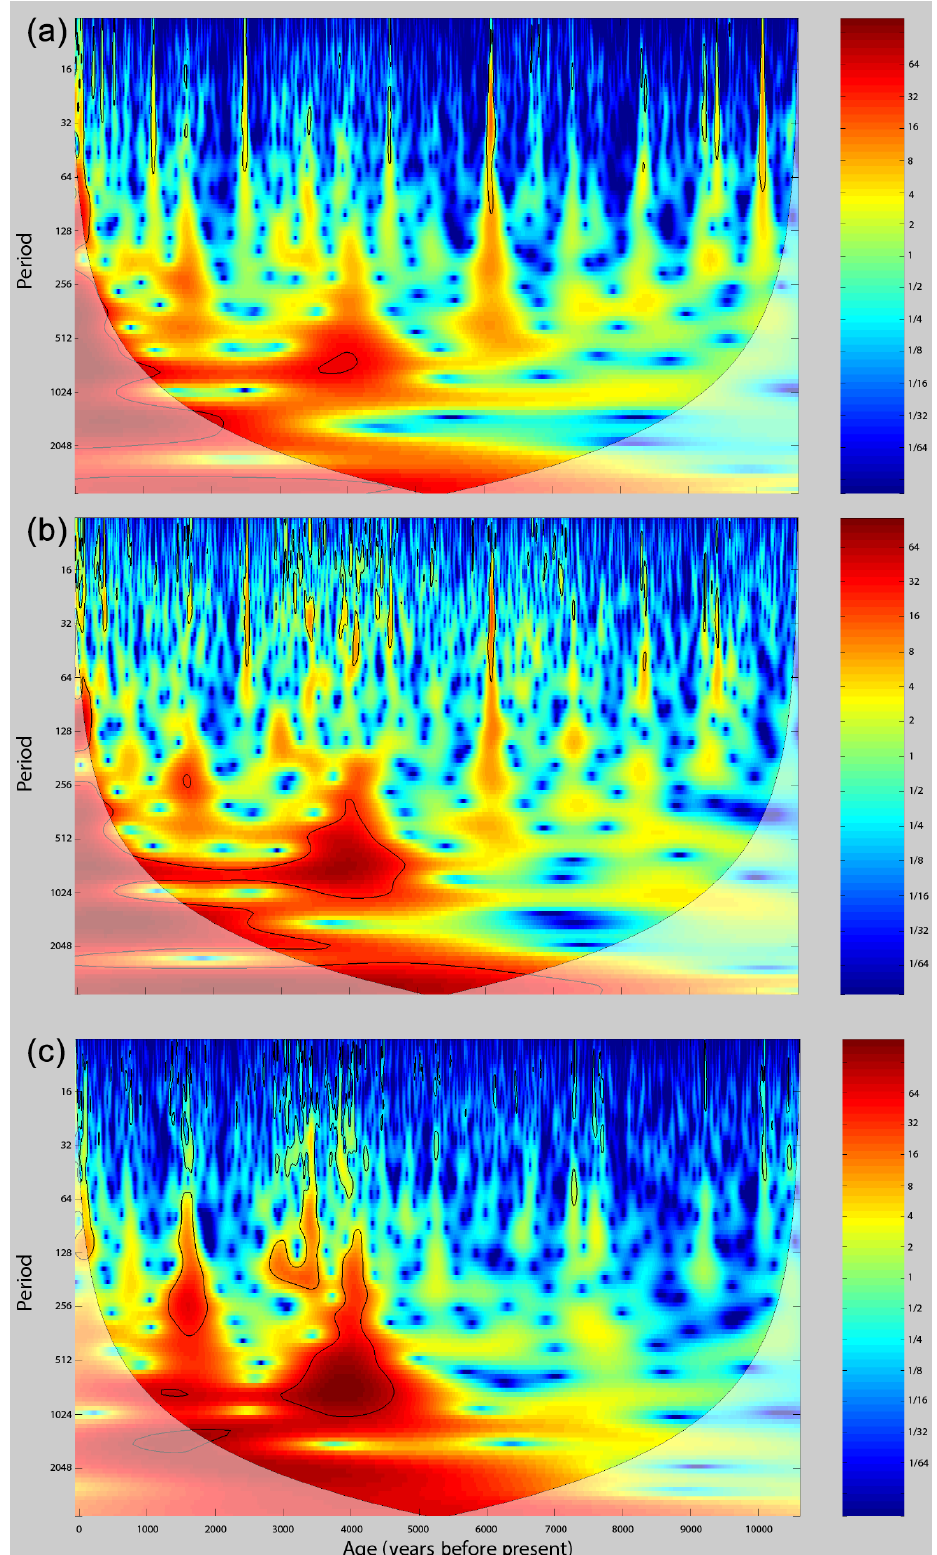
Figure 8. Spectral analysis of Mohos Itrax geochemical data for (a) K, (b) Si, and (c) Ti. Areas outlined in black are significant at the 95% confidence level. Shaded area indicates the cone of influence, outside of which results may be